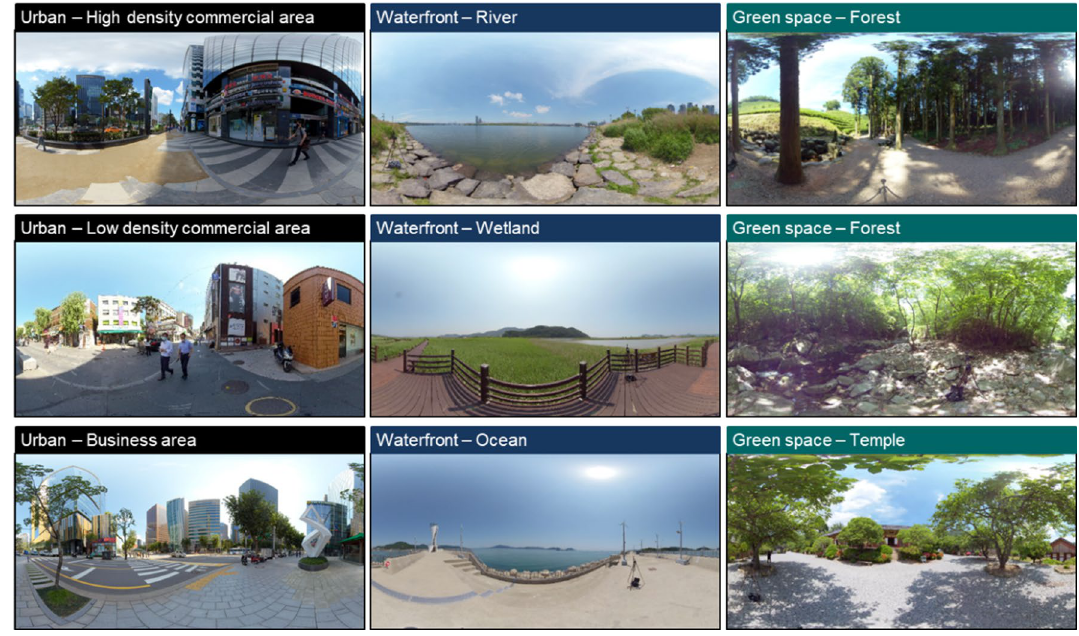
Figure 1. Stitched monoscopic 360-degree view of nine evaluation sites: urban, waterfront, and green